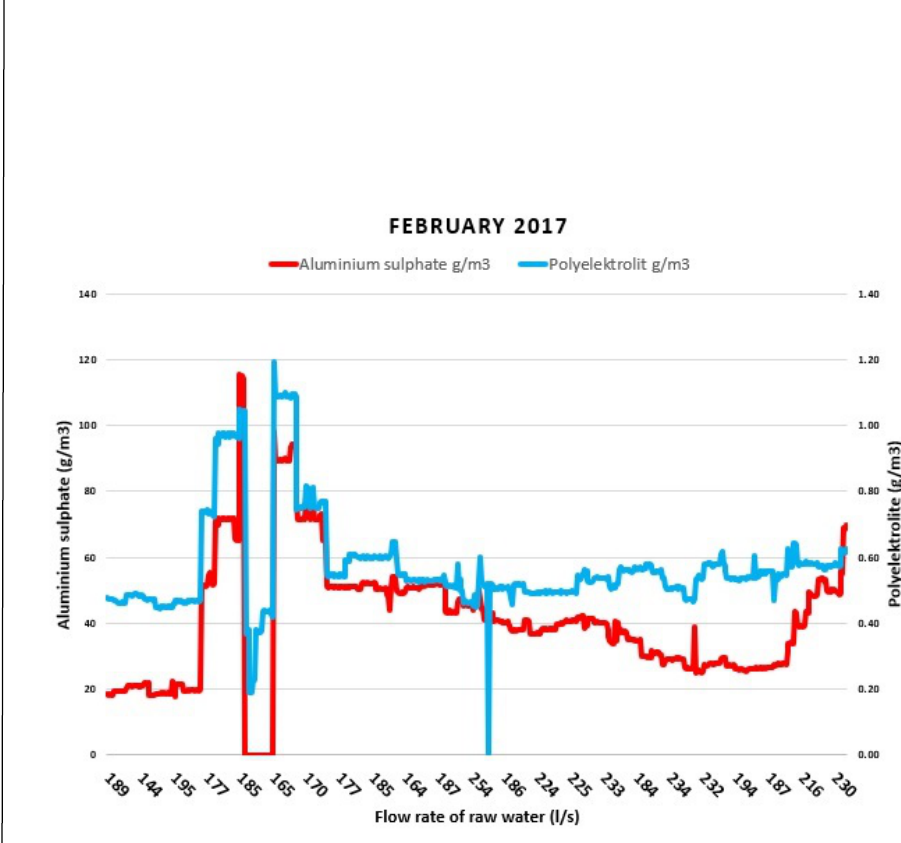
Figure 3a – Dependence of the concentration of added aluminum sulphate and polyelectrolyte on the flow rate of raw water during February